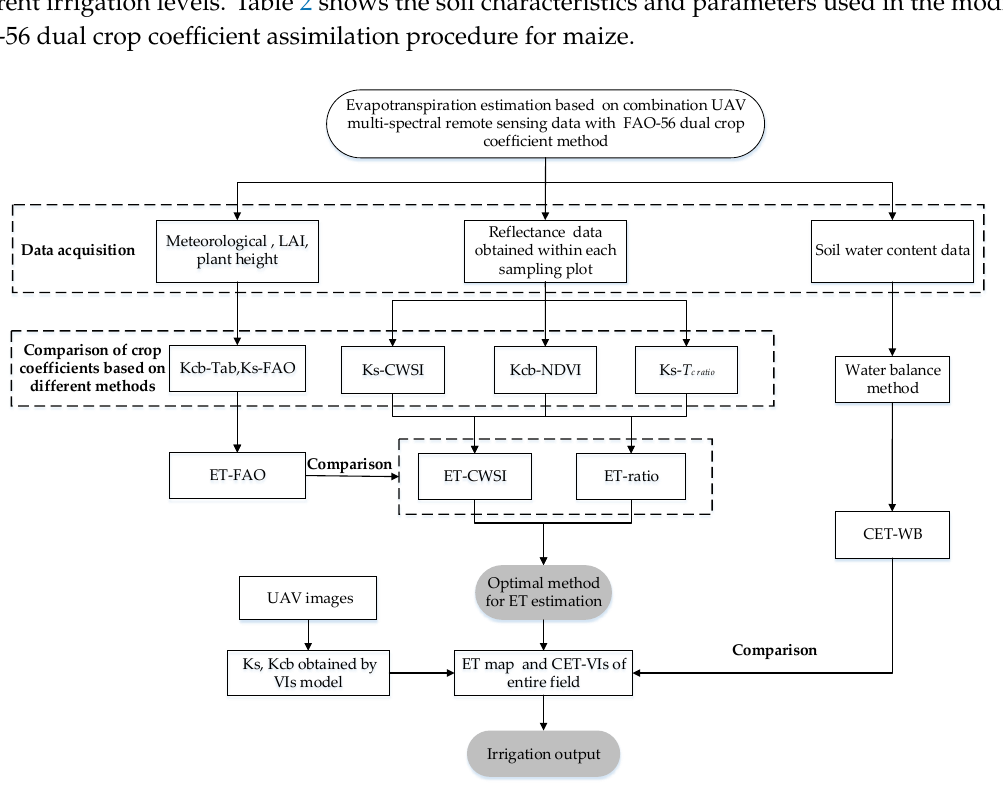
Figure 2. Hierarchical framework integrating the data obtained from an unmanned aerial vehicle (UAV) remote sensing system and ground measurements into the FAO-56 dual crop coe ffi cient method. LAI, leaf area index; CWSI, crop water stress index; NDVI, normalized di ff erence vegetation index; Kcb, basal crop coe ffi cient; Ks, water stress coe ffi cient; CET, cumulative evapotranspiration; VIs, vegetation indices; WB, soil–water